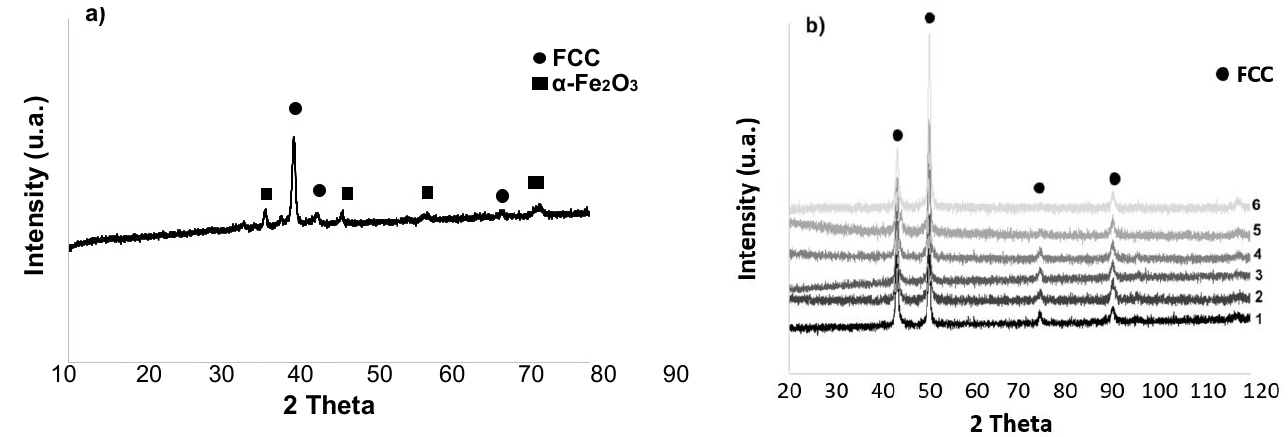
Figure 2. ( a ) XRD of mechanically alloyed powders; ( b ) XRD of the HEA after layer by layer abrasion (from 1 to 6). Overall removed thickness is 0.5 mm. Peaks are due to FCC Cantor’s alloy (card number 00-033-0397), Fe 2 O 3 (card number 01-085-0599).